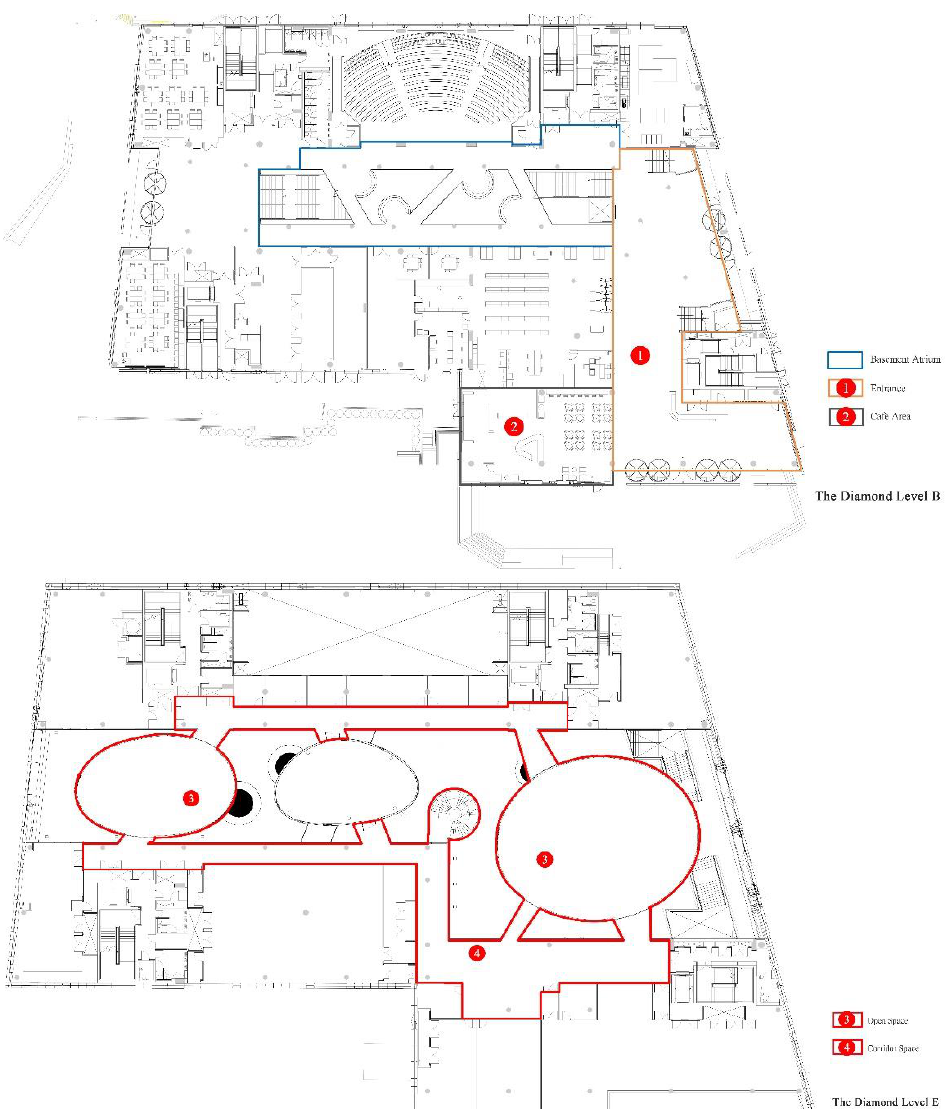
Figure 2. Atrium Space of the Diamond at University of Sheffield.